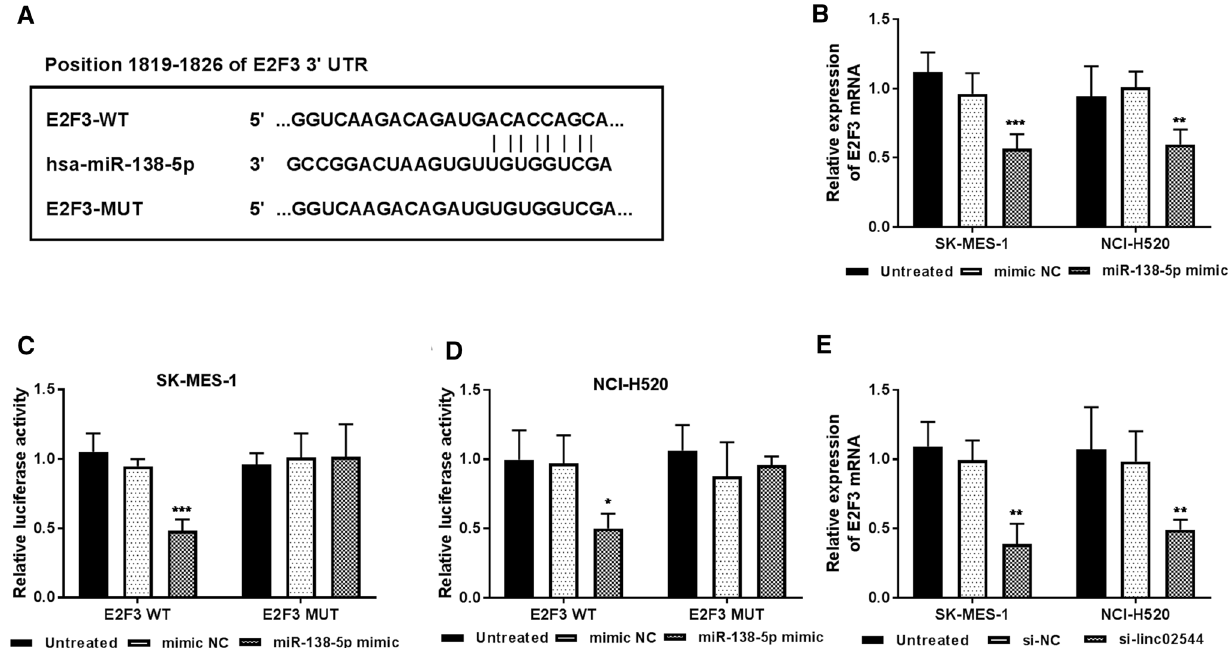
Fig. 5 E2F3 may be a downstream target of miR-138-5p. A The binding sites between miR-138-5p and E2F3. B Overexpression of miR- 138-5p decreased the E2F3 mRNA levels compared with that in untreated cells. C and D miR-138-5p repressed the luciferase activities of E2F3 WT-3’-UTR but no effect on the E2F3 MUT-3’-UTR. E The E2F3 mRNA levels were decreased in cells transfected with si-linc02544 com- pared that in untreated cells. * P < 0.05, ** P < 0.01, *** P <